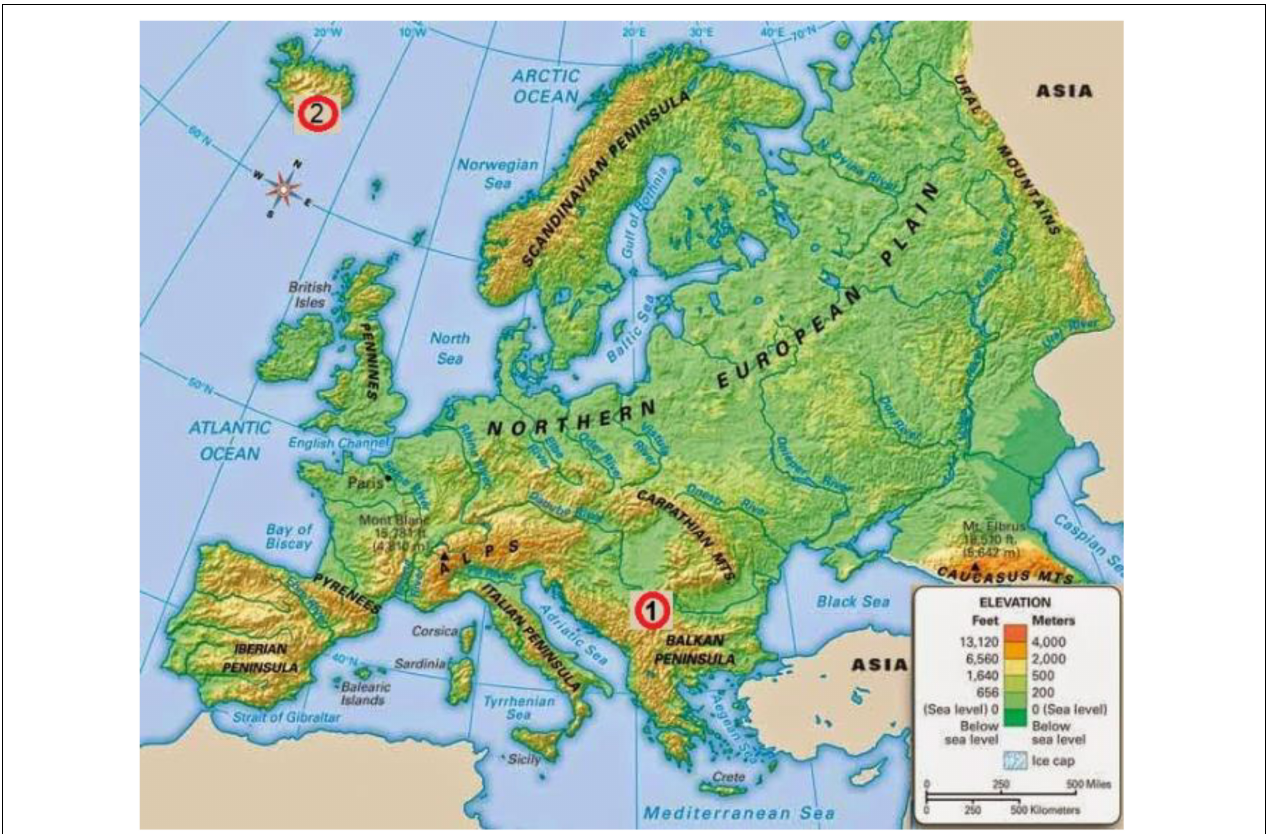
FIGURE 1 | Map of Europe and sampling sites for atmospheric aerosols: Belgrade (cid:172) and the Rangárvellir area (cid:173) . https://2.bp.blogspot.com/-LVIaPBN2nvA/ VNECxS7jCPI/AAAAAAAAATc/Whc6_-9OKzc/s1600/Geography%2Bof%2BEurope.jpg.